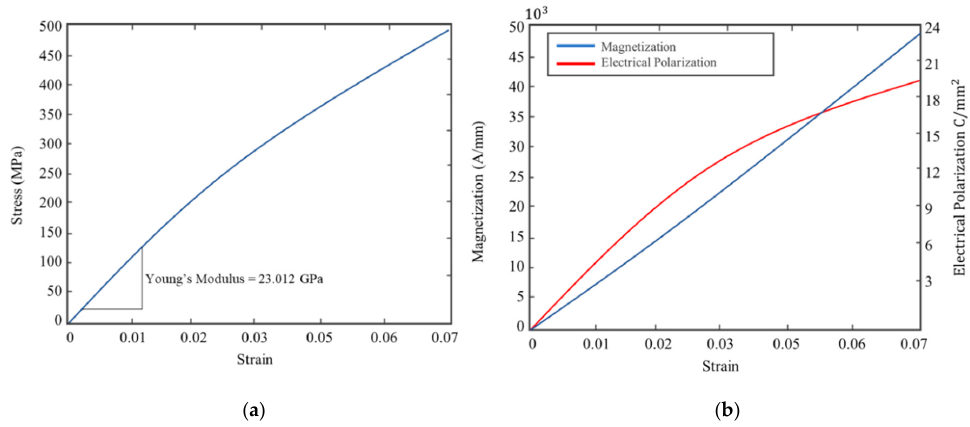
Figure 6. ( a ) Stress–strain response of the smart self-sensing composite; ( b ) magnetization and electric polarization or the composite with change in strain.